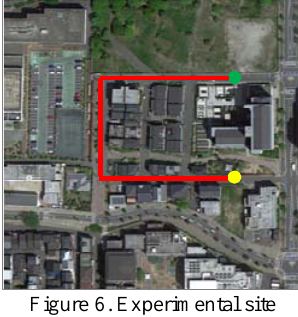
Figure 8. Result of position with POS sensor fusion